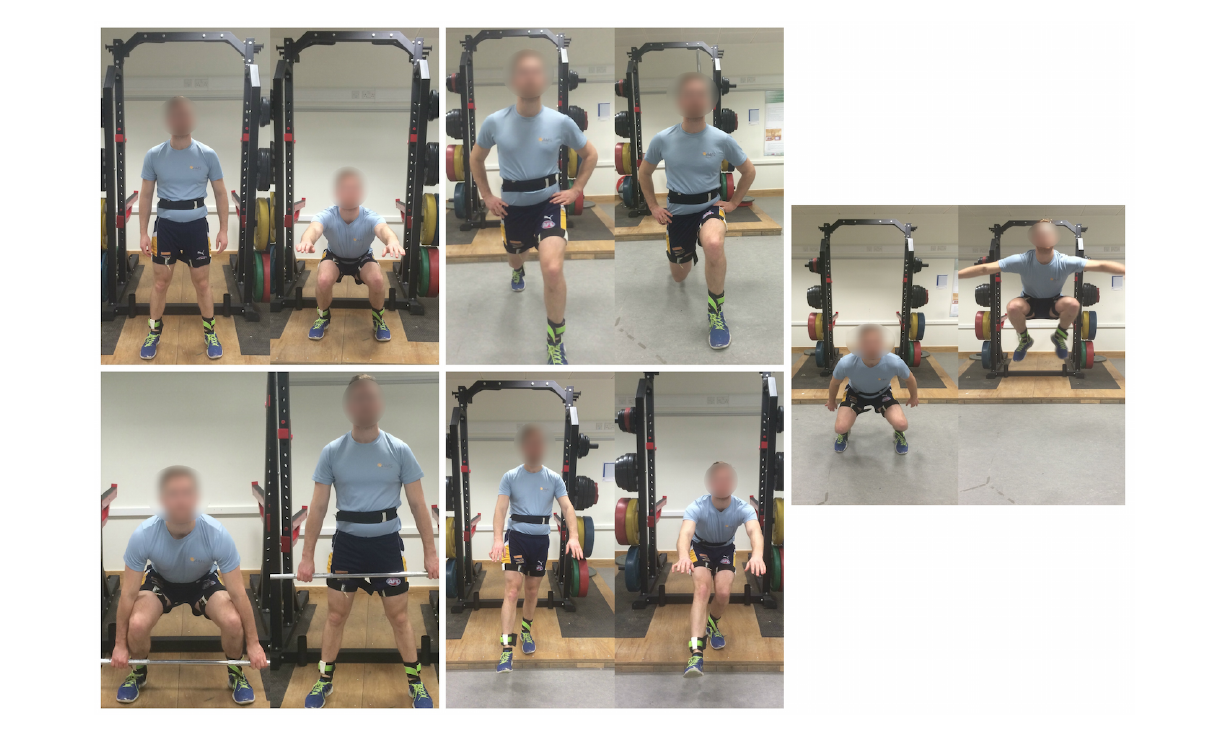
Figure 4. The five exercises completed for this study: bodyweight squat (upper left), bodyweight lunge (upper middle), barbell deadlift (lower left), single leg squat (lower middle), and tuck jump